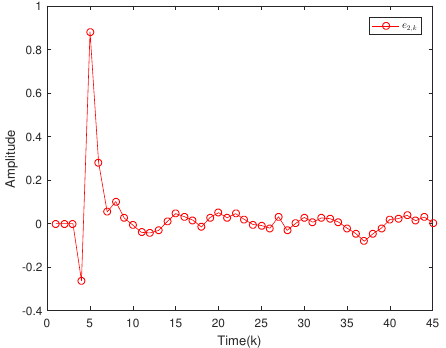
Figure 6. Filtering error e 2, k under the RAP scheduling.